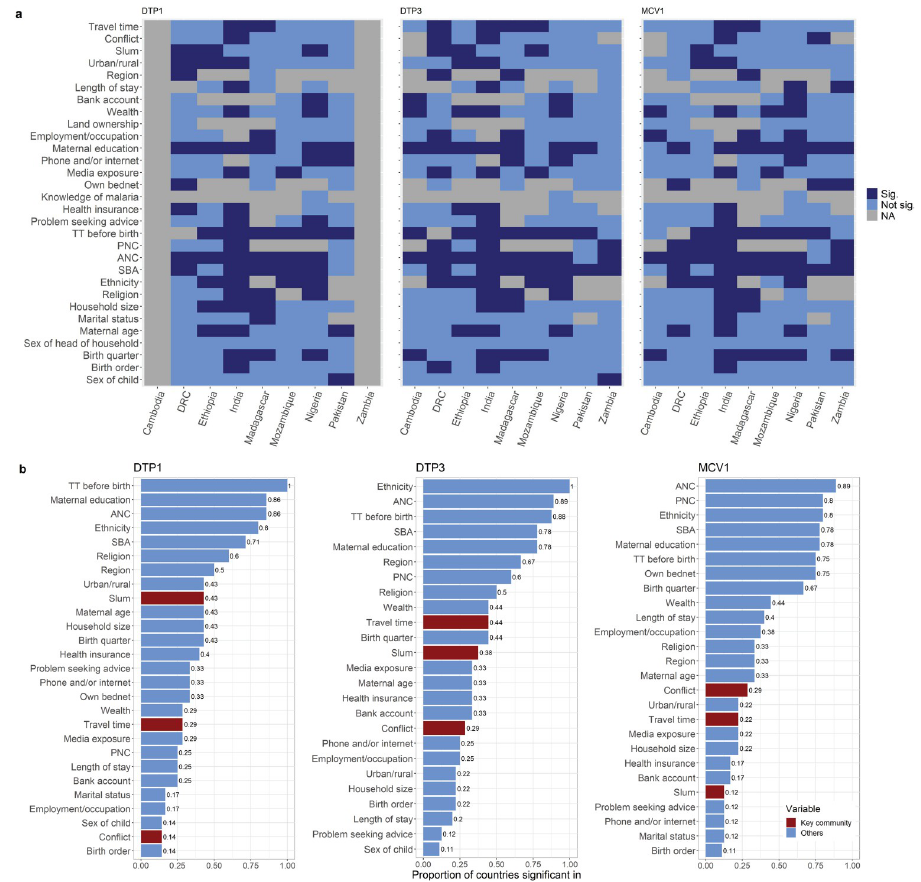
Fig 4. Summaries of multivariate analyses results. (a) A summary of the estimated relationships showing significant (sig.) and non-significant (not sig.) predictors of non- and under-vaccination in the multivariate analyses (missing variables are due to unavailability of data or multicollinearity); (b) Ranking of significant predictors of non- and under-vaccination in the study countries. For each vaccine dose, the ranks are based on the proportion of countries in which each variable was statistically significant in the multivariate analyses. Only variables found to be significant are